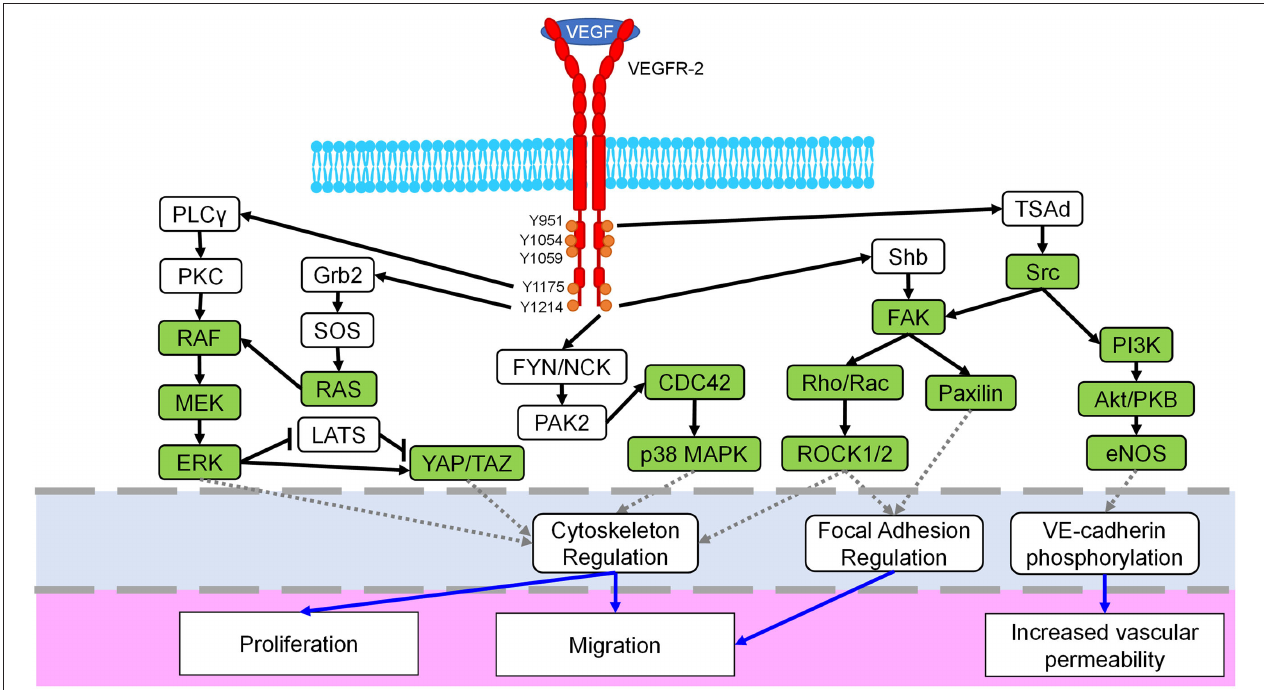
FIGURE 2 | Mechanosignaling in the VEGFR-2 pathway. The VEGFR-2 receptor (red) dimerizes when bound by the VEGF ligand, spans the cell membrane (blue) and possesses multiple phosphorylation sites in the intracellular domain (orange). Downstream signaling initiated by VEGFR-2 includes several known mechanotransductive proteins and enzymes (green) including the MEK/ERK, Rho/ROCK, Src, and YAP/TAZ pathways. Crosstalk between related pathways, i.e., ERK/p38, are not shown for the sake of clarity. The primary target of each pathway is identified with a dashed gray line (light blue region) and includes cytoskeletal regulation, focal adhesion regulation, and VE-cadherin signaling. Finally, resulting cellular phenotypes for each mechanosignaling pathway are indicated with a solid blue arrow in the lowest region of the figure. Figure was derived based on the following references: (23, 24,